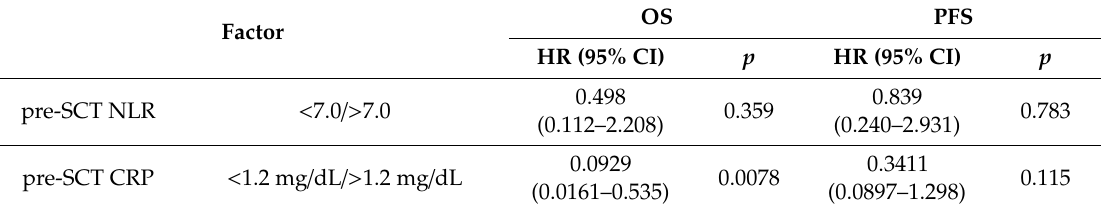
Table 4. The multivariate analysis of factors associated with overall survival and progression-free survival in patients administered salvage chemotherapy with PC (reference to PS, Sex, and